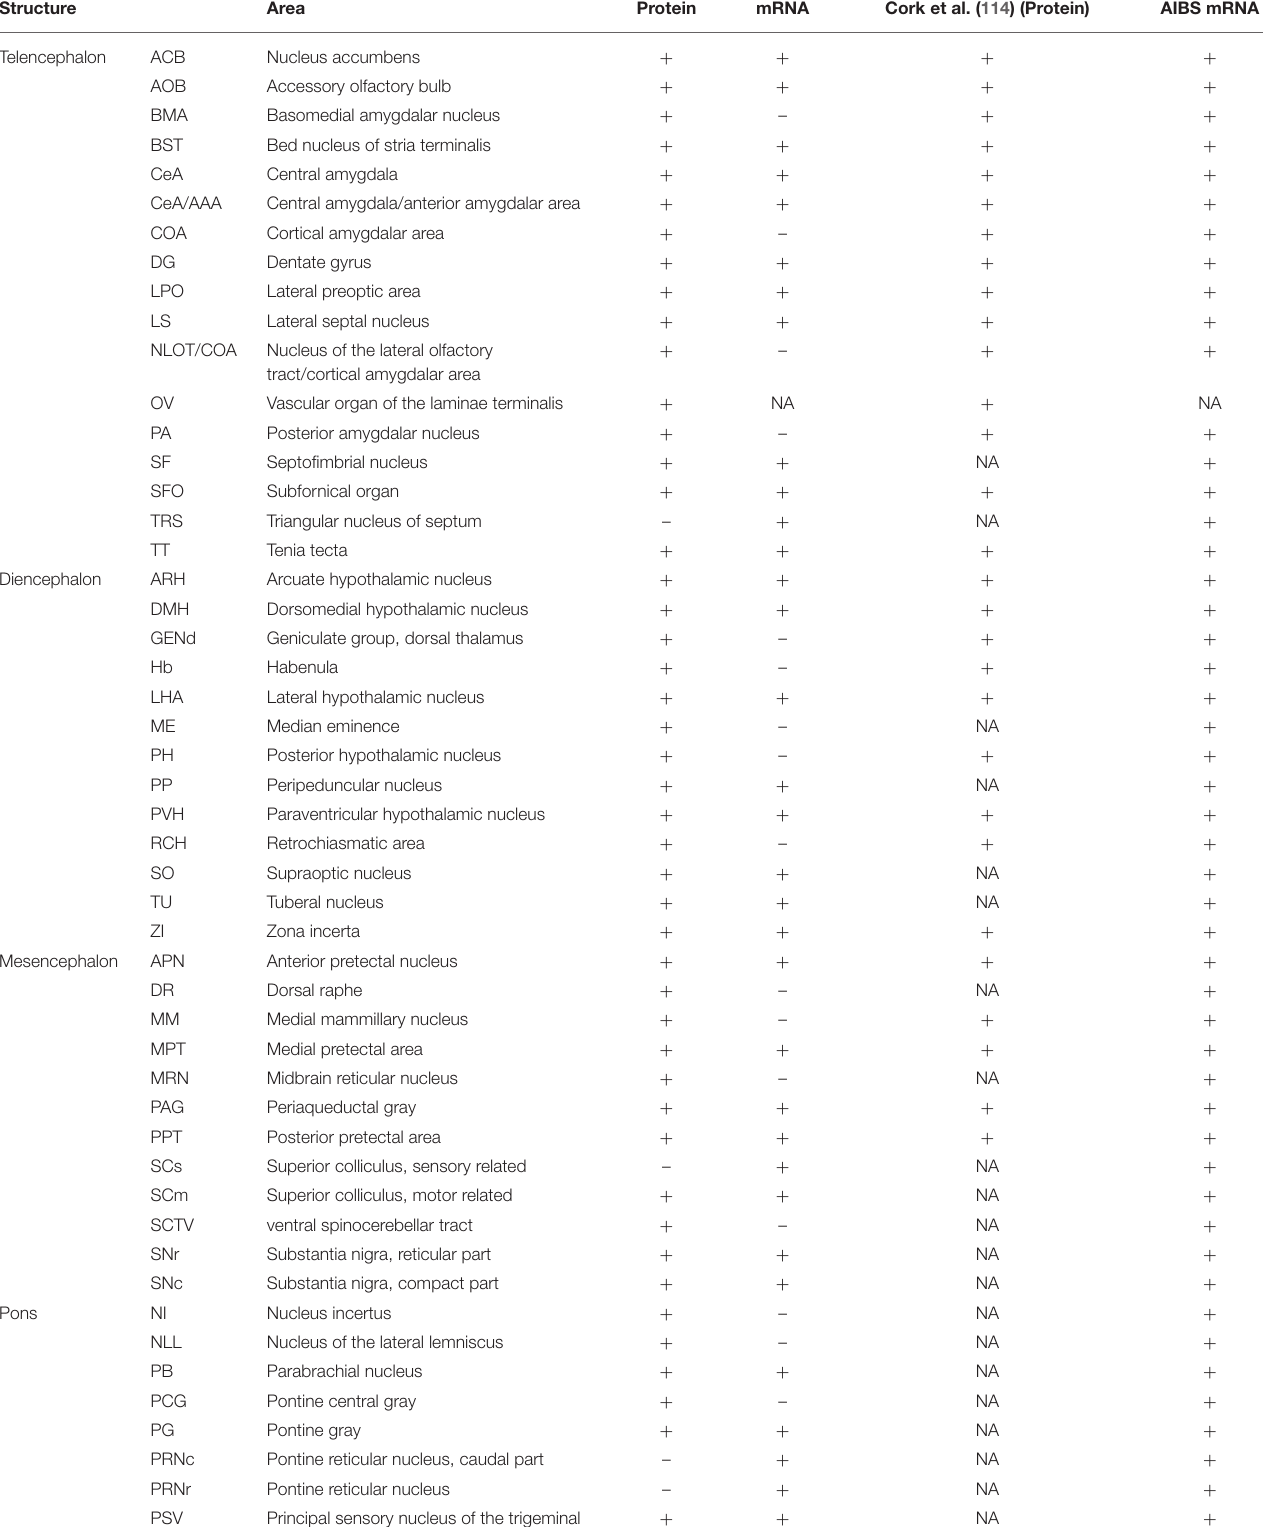
TABLE 2 | Summary of GLP-1 receptor location in the mouse brain and comparison with external references. Structure